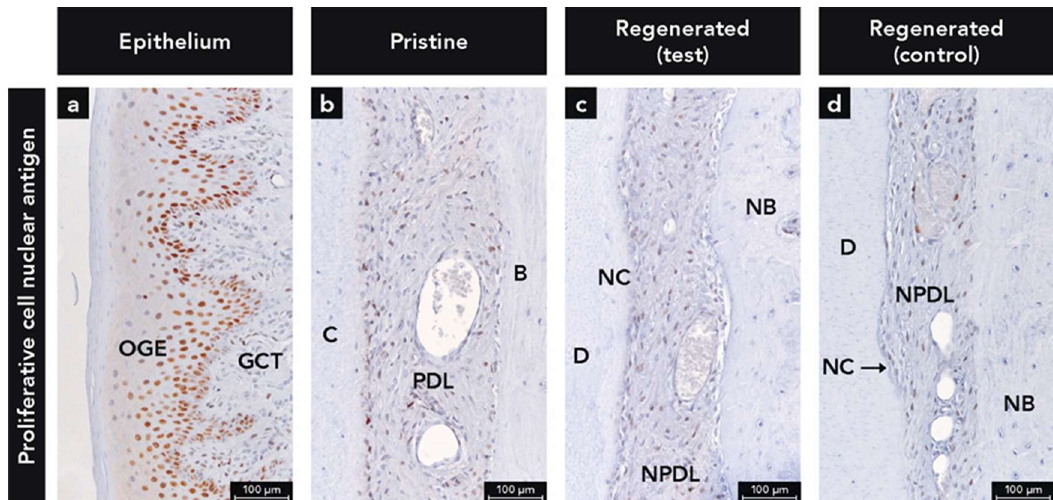
Figure 6. Immunohistochemical staining for proliferative cell nuclear antigen (PCNA); ( a ) Micrograph demonstrating PCNA+ cells in the oral gingival epithelium (OGE); ( b – d ) Micrographs showing PCNA+ cells in the pristine and regenerated periodontal ligament (PDL); Counterstaining: Mayer’s hematoxylin; B, bone; C, cementum; D, dentin; GCT, gingival connective tissue; NB, new bone; NC, new cementum.